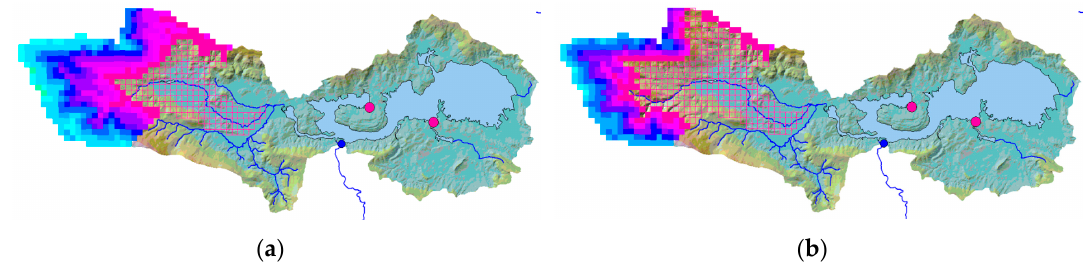
Figure 7. ASTER hydrological model snow accumulation (snow–water equivalent) ( a ) Day 1, ( b ) Day 2. Hijar model (ranging from 1 mm–pink to 215 mm–cyan).